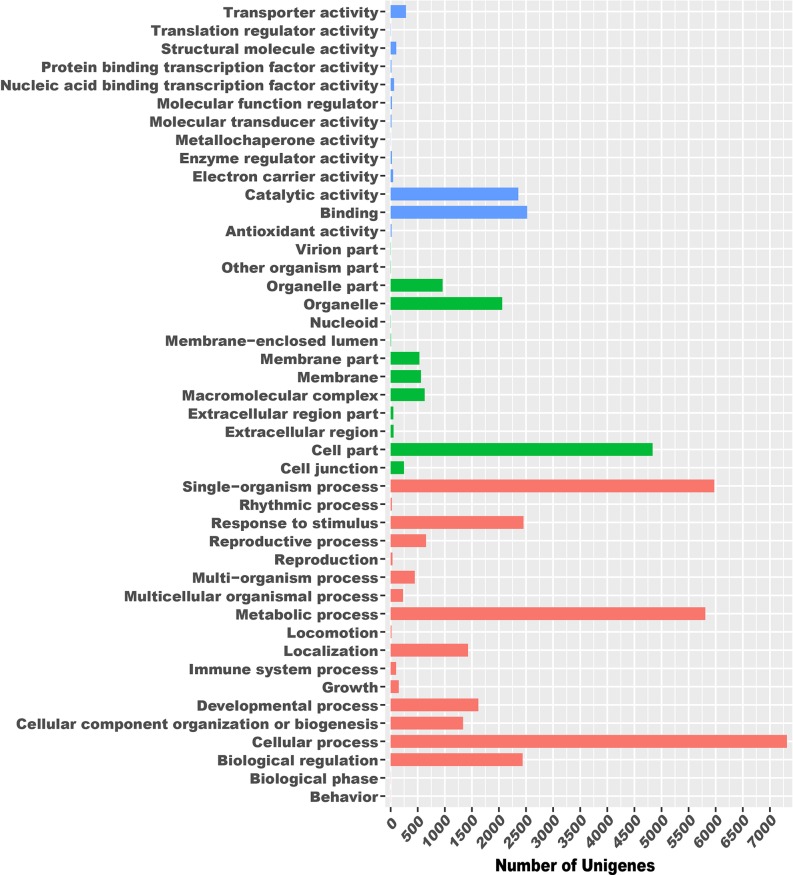
Functional classification of Gene Ontology for Amentotaxus argotaenia unigenes.